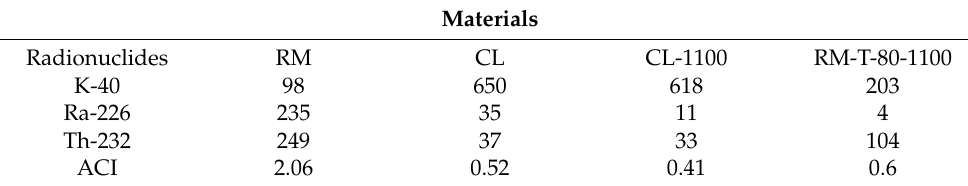
Table 8. Radionuclide activity concentrations (Bq/kg) and activity concentration indexes